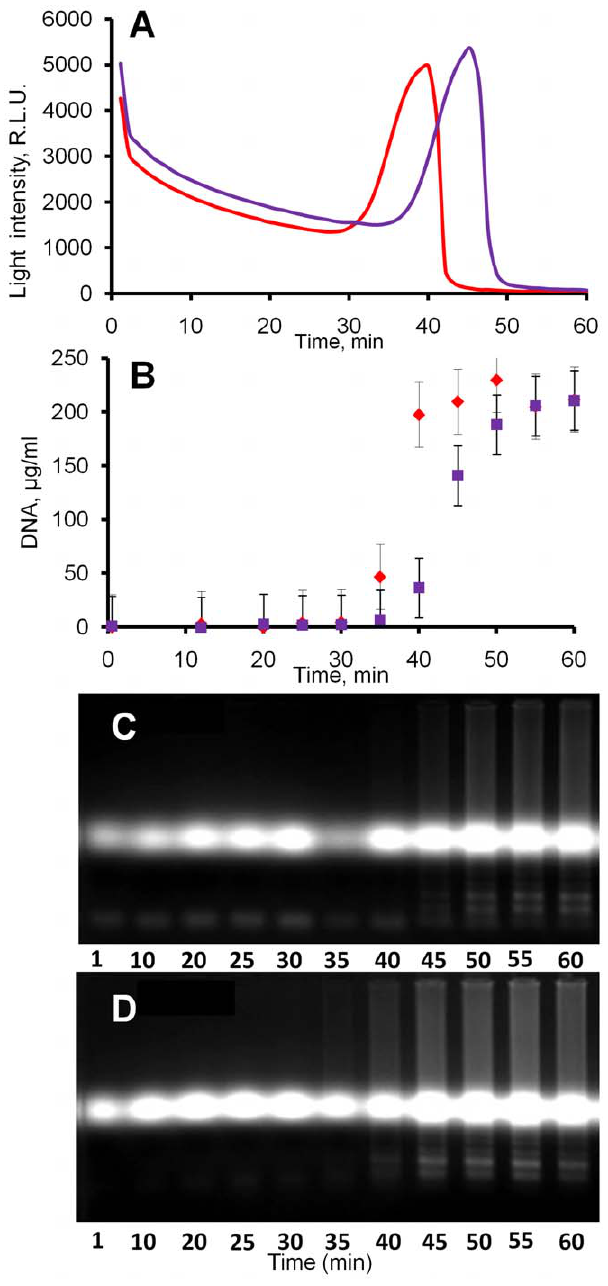
Figure 4. Correlation between bioluminescent output and DNA production in LAMP-BART. Light output in BART (A) and DNA yield assayed by end-point fluorescence method (B) and visualised by gel- analysis (C, D) for two different amounts of ChAT (1 pg/ml – blue, 100 pg/ml - red). Each curve represents one of three replicates. 2% agarose gel shows LAMP amplicon as a ladder of bands representing multiple concatamer repeats of the ChAT template using 1 pg/ml (C) and 100 pg/ml (D) of starting template. The strong band in all lanes corresponds to luciferin, which is strongly fluorescent under UV